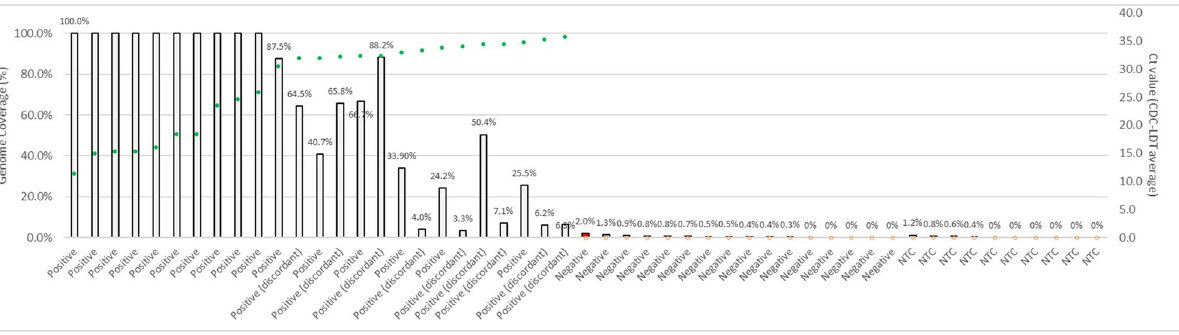
Figure 3. Correlation between viral genome coverage (%) by next generation sequencing (NGS) and cycle threshold (Ct) values for SARS CoV-2. NGS is a sensitive method of detecting low-level SARS-CoV-2 virus in clinical samples, and coverage (%) of the genome is correlated to the Ct value determined by RT-PCR. Thirty samples (17 saliva and 11 SN swabs and 1 NP swab) were tested by NGS. Ten samples (4 saliva, 6 SN swabs) with discordant results from the RT-PCR tests were confirmed to be positive by NGS (median genome coverage 29.7%, range 3.3–88.2%). Genome coverage (%) is defined as the proportion of the SARS-CoV-2 genome that has > 1× depth of coverage. The threshold coverage (%) for making positive call by NGS was established by running 5 negatives (by RT-PCR) samples from this study, 11 negative NP swab samples from community testing, and 10 no-template controls (NTC). The threshold was determined to be the detection of 5 amplicons, which corresponds to a coverage of ~ 1.7% of the SARS-CoV-2 genome. Among five negatives (by both